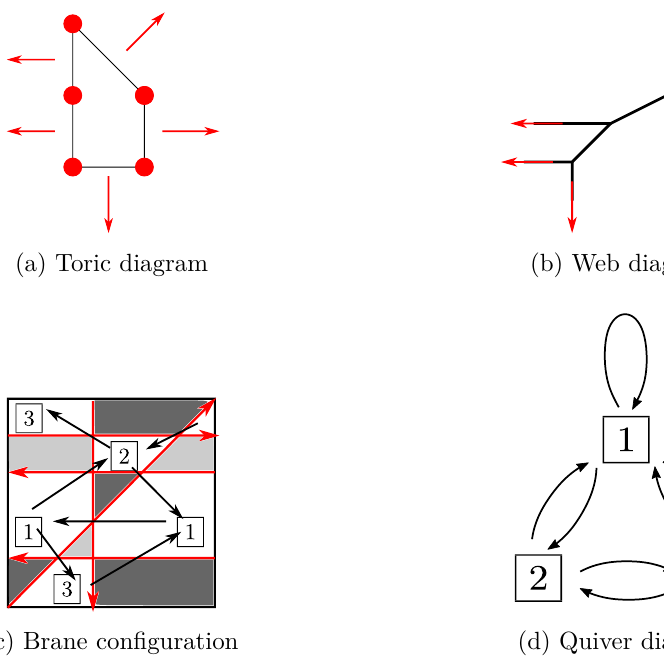
Figure 14. Toric diagram, web diagram, brane configuration, and quiver diagram for the Suspended Pinch Point (SPP) singularity. (a) Toric diagram for the SPP. (b) The web diagram of the SPP. It is dual to the toric diagram. The red arrows are called external lines from now on. (c) The rectangle is a fundamental domain of the torus T 2 and the boundary is identified periodically. The red lines physically correspond to NS5-branes, which divide the fundamental domain into several domains: dark gray, light gray, and white. The white regions are assigned vertices, and there are arrows between each vertex. The orientation of the arrows is defined so that the light gray domain is always on the left of the arrowhead. (d) Quiver diagram obtained from the brane